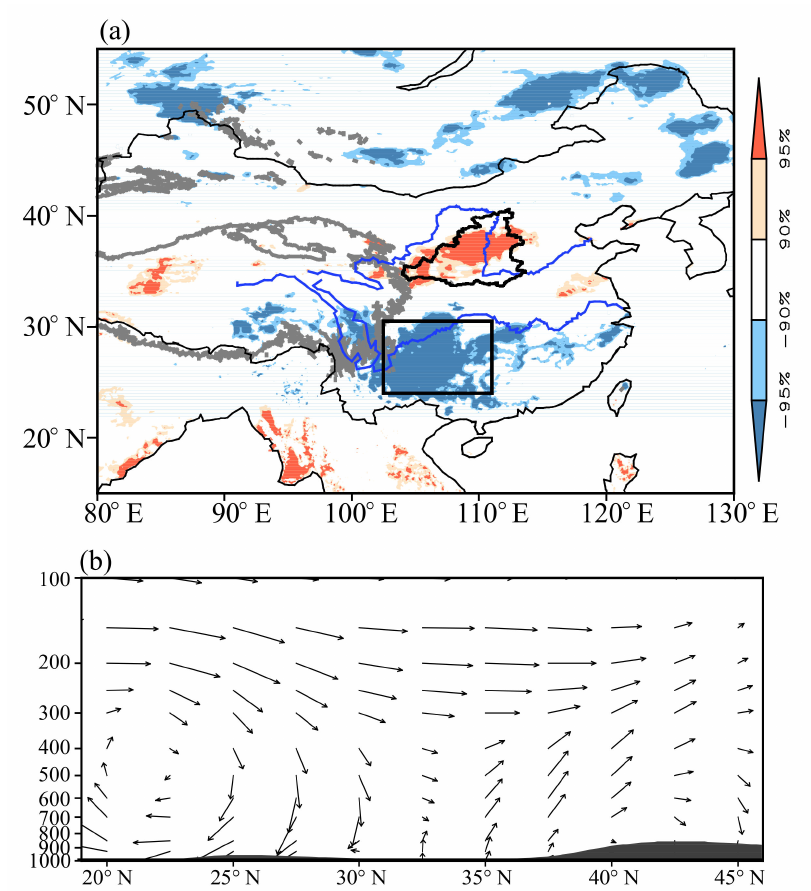
Figure 6. ( a ) Distribution of correlation coefficients between the July–August YGP SM index and SM during the subsequent September SMs during the period 1979–2021. Shadings denote the correlation significant at the 90 and 95% confidence levels, as shown by the color bars. The black bold borderline around the Yellow River (the blue curve in northern China) represents the MRYR region and the thick gray contour denotes the Tibetan Plateau (3000 m above sea level); ( b ) September vertical circulation anomalies regressed upon the simultaneous YGP SM index on a meridional–vertical cross section along 110 ◦ E. The September area-mean SM averaged in the YGP region (24–30.5 ◦ N, 102.5–111 ◦ E; see the black box in ( a )) was defined as the September YGP SM index. The gray shading in ( b ) represents the